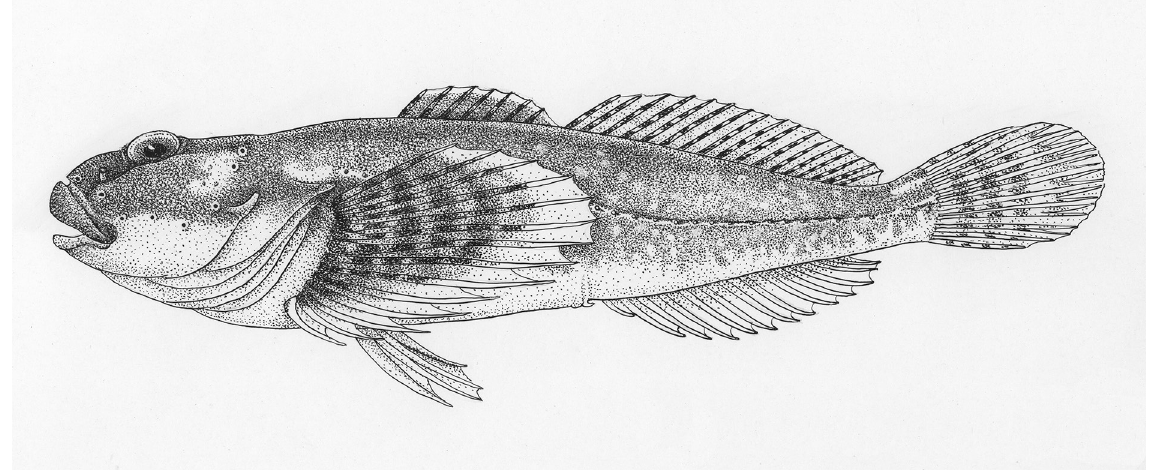
Fig. 3 . The zoological picture of the holotype of Cottus cyclophthalmus sp. nov. (ZIN 56687), SL 83.3 mm, lateral